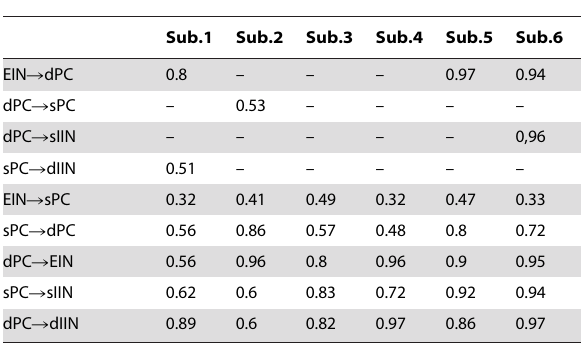
Table 3. Synaptic efficacies at the time point of the fifth stimulus (when the habituation is usually converged, the synaptic efficacies at the 2nd, 3th, 4th and 5th stimulus are listed in Table